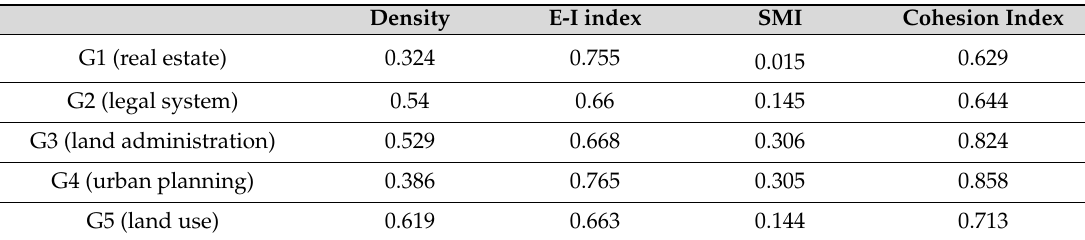
Table 1. Group Table 1. Group density.